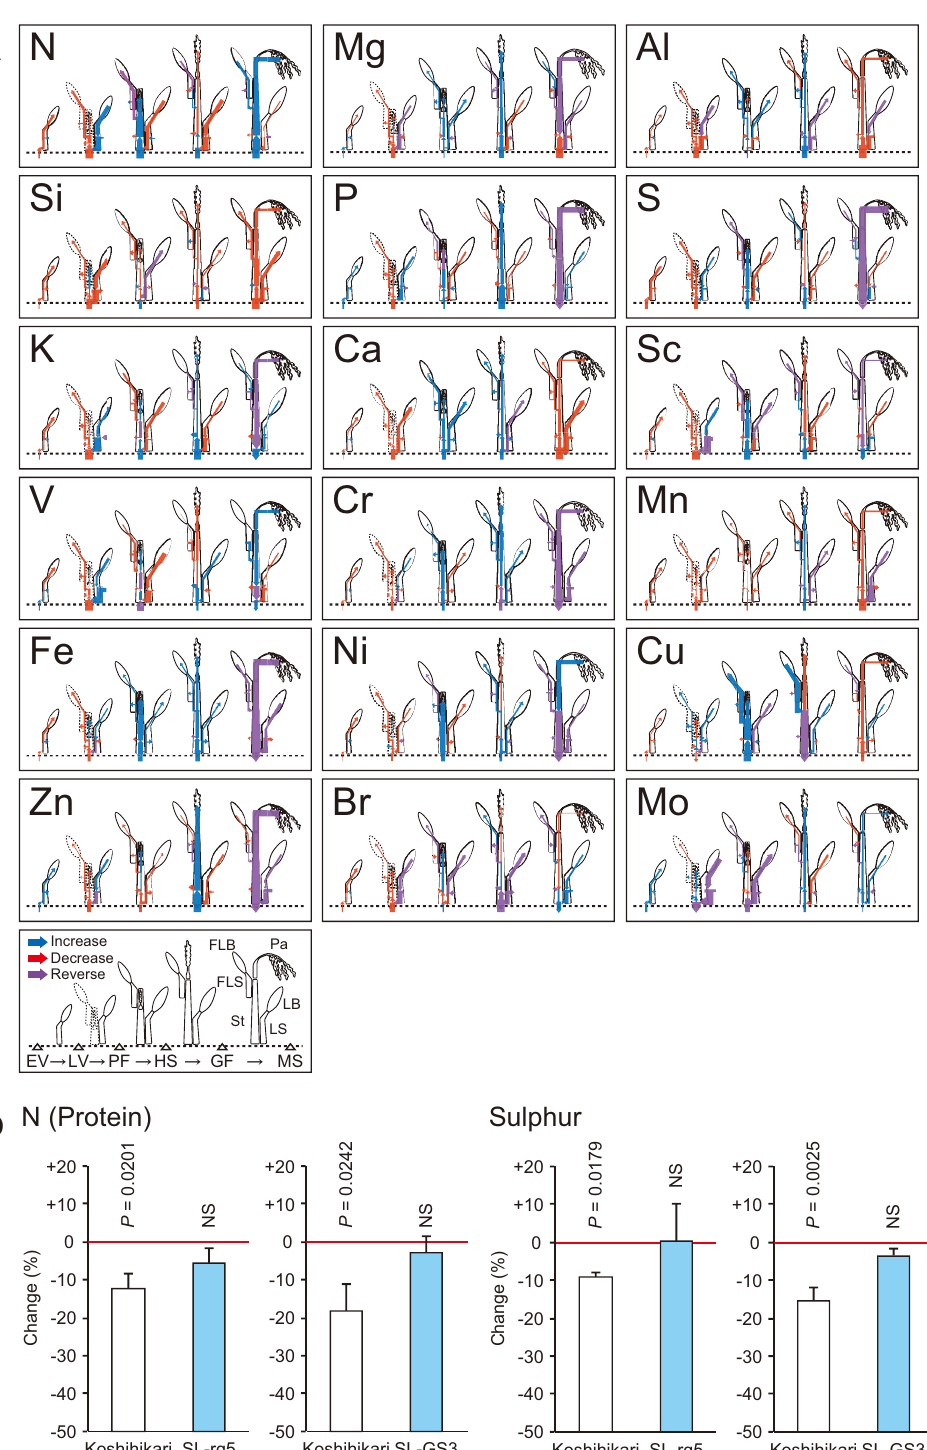
Fig 2. Influence of elevated [CO 2 ] on flow of elements in a rice plant during growth, and genetic improvement to prevent elemental reduction in grains. (a) Change in elemental flow in rice (“ Koshihikari ”) under elevated [CO 2 ] as compared with ambient [CO 2 ]. Arrows indicate the direction of elemental flow: blue shows an increase, red a decrease, and grey no change under elevated [CO 2 ] versus ambient [CO 2 ]. Purple arrows indicate that the direction of flow was reversed by CO 2 treatment. The extent of the change in flow is indicated by arrow width; the part of the plant